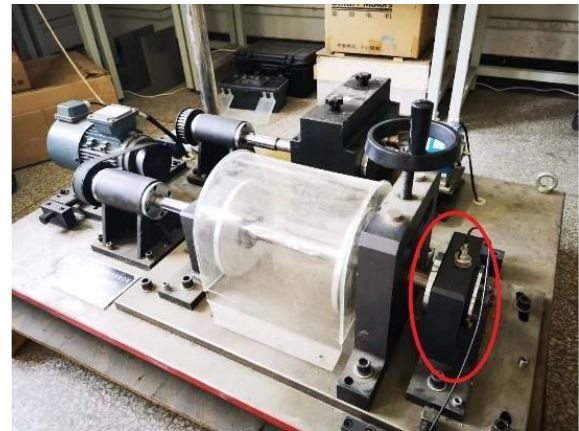
Figure 3. Bearing Simulation Fault Platform.